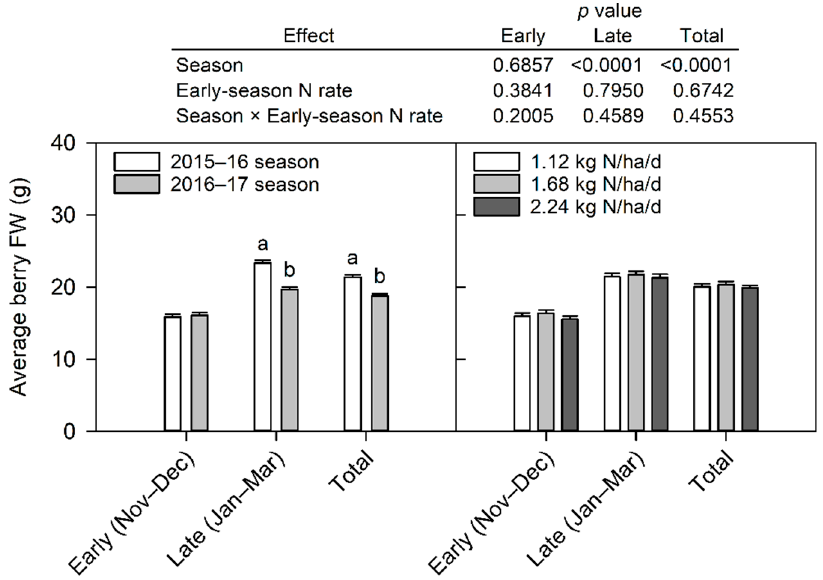
Figure 2. Average berry fresh weight (FW) of ‘Florida Radiance’ strawberry as affected by season and early-season nitrogen (N) fertilization rate. Fertilization treatments are as described in Table 1. November to December and January to March harvests were classified as early and late season yields, respectively. Data are means ± SE. Data were pooled by each main effect, as they were not significantly affected by the season × early season N rate interaction ( p > 0.05). Within each yield group, bars followed with the same letter are not significantly different (Tukey–Kramer test, p ≤